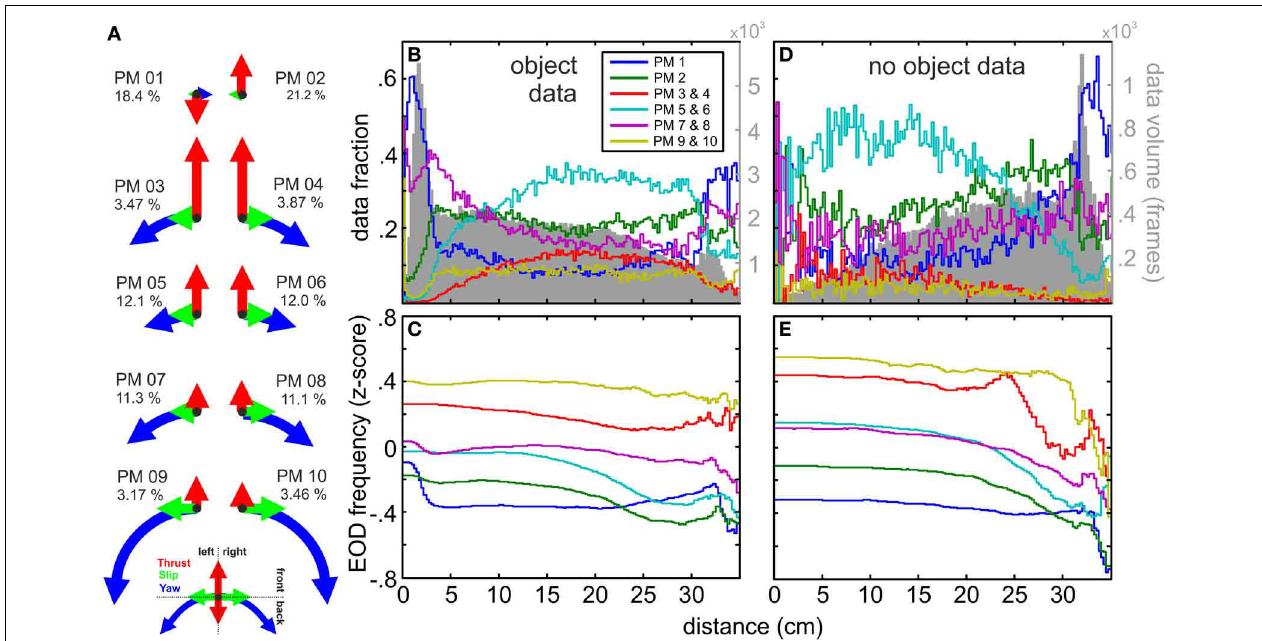
FIGURE 2 | Kinematic composition of prototypical movements (PMs), spatial distribution and relation to fEOD. (A) Normalized thrust, slip and yaw velocity amplitudes for centroid values of the 10 clusters and the data fraction of each PM relative to the size of the entire dataset ( n = 277585). PMs 3–10 occurred in mirror-imaged pairs with respect to their slip and yaw velocity directions. PM 1 and PM 2 were mainly thrust dominated; note that thrust was negative for PM 01. Mirror-imaged PMs occurred equally likely (see percentage of each PM). PMs 3–10 describe a gradual transition from PMs with maximal translational amplitude (PM 03/04) toward those of maximal rotational amplitude and reduced thrust (PM 09/10). (B) Relative spatial distribution of the PMs plotted against the Euclidian distance to the object for nights in which an object was placed in the tank ( n = 231355 frames). PM 01 and PM 07/08 were the most common PMs close to the object, while the other PMs declined in their relative frequency. The absolute